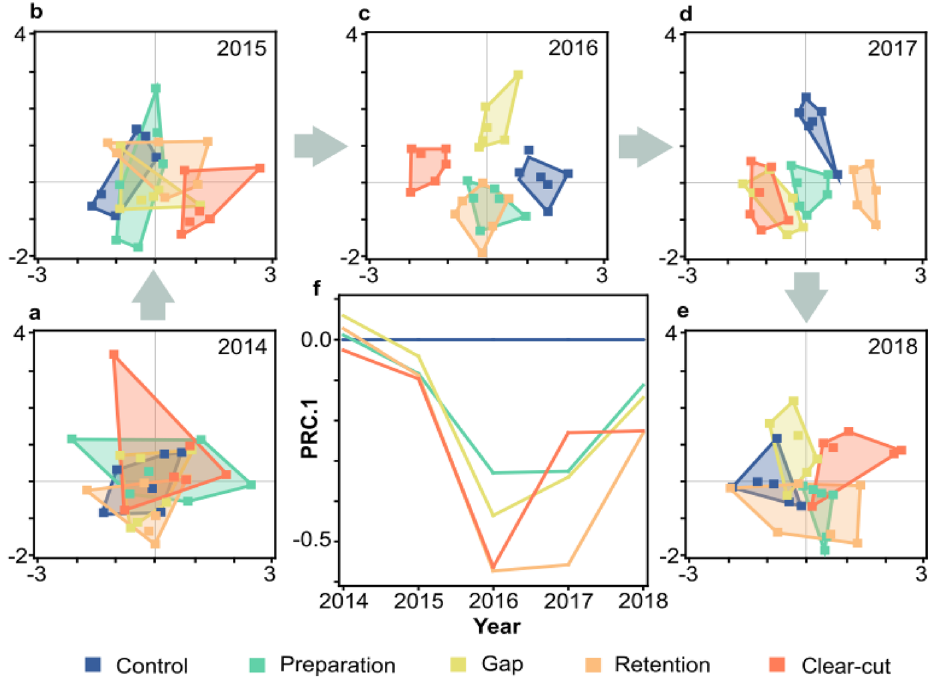
Figure 3. Unconstrained ordination plots of the spider communities in different treatment plots over the study years. ( a-e ) Principal Components Analysis ordination of treatment plots, grey arrows indicating the sequence of years; ( f ) Principal Response Curves plot of treatments relative to control. Treatments are colour coded according to the legend. The first two axes of the PCAs explained cumulative variation between 2014 and 2018 as follows: 41.71%, 48.53%, 68.19%, 56.63% and 44.10%, respectively. PRC.1 axis explained 64.01% of fitted variation.